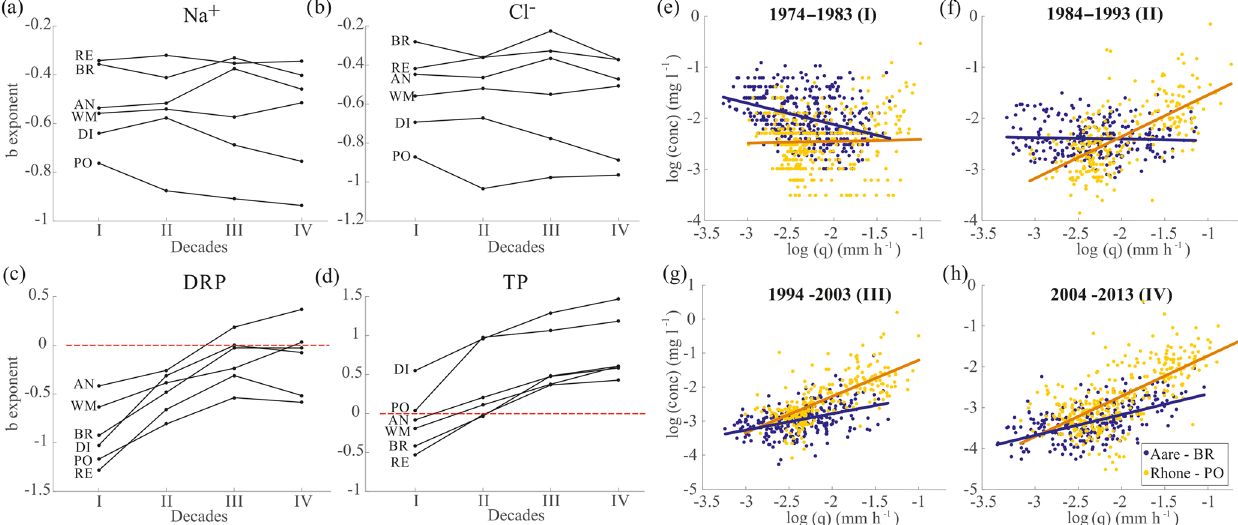
Figure 8. Analysis of temporal variations of the b exponent. (a–d) represent the values of the b exponent of the C – Q empirical relation ( C = aQ b ) of (a) Na + , (b) Cl − , (c) DRP, and (d) TP across four decades from 1974 to 2013 – (i) 1974–1983, (ii) 1984–1993, (iii)